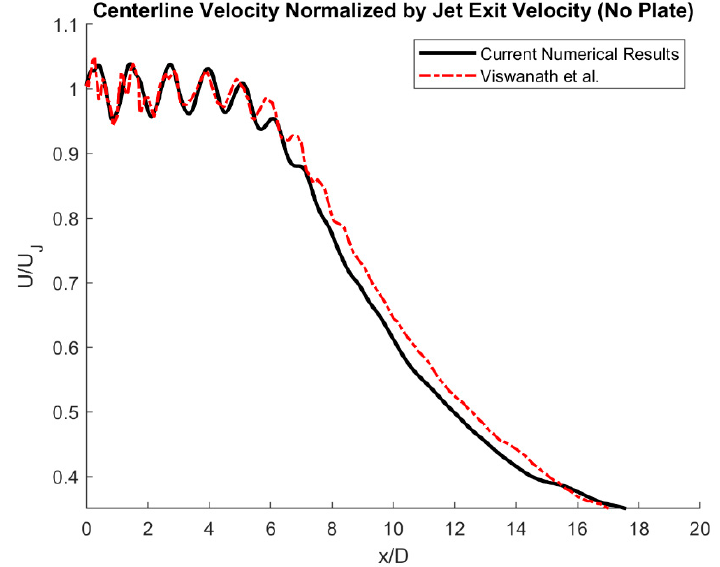
Figure 24. Time-averaged center line velocity (no plate).